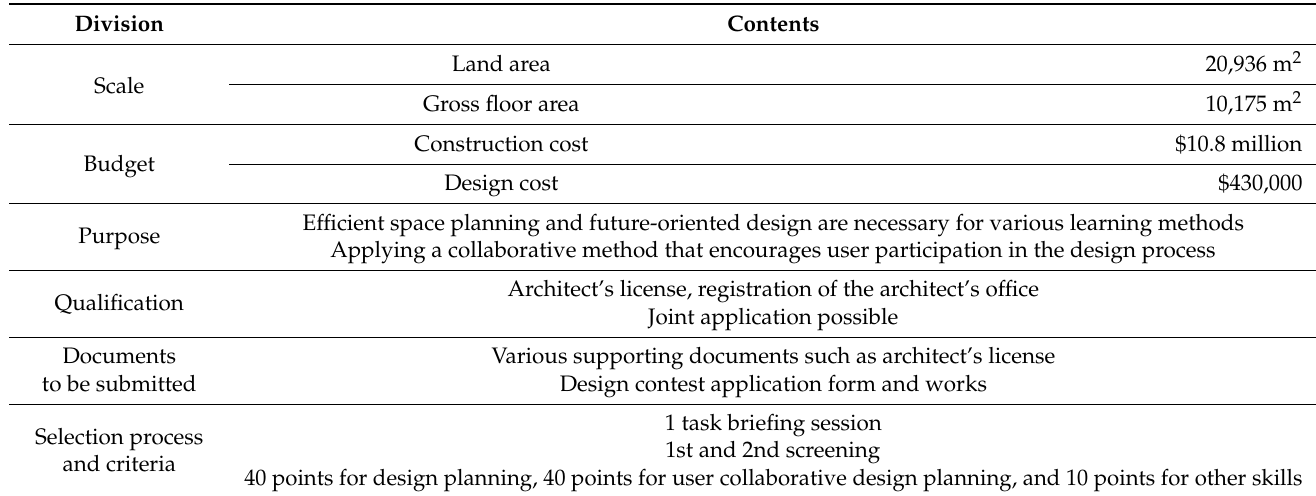
Table 2. Content of the design competition announcement for selection of an architect for the SEES